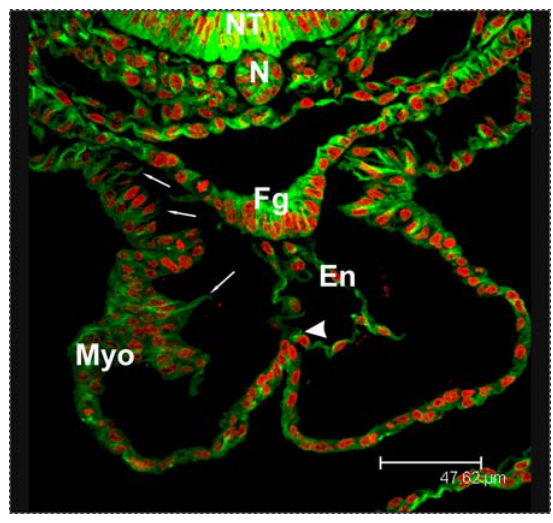
FIGURE 6 . HH stage 11 chick heart immunostained for acetylated tubulin. Myocardial cell processes extending into the cardiac jelly (see arrows) do not express acetylated tubulin that is observed usually in microcilia (arrowhead) and that are associated with endocardial-endothelial cells. This lack of tubulin expression in cardiomyocyte cell extensions into the ECM of the basal lamina and the RGD experiments suggest that myocardial mechanosensing of forces associated with blood flow would most likely be through integrin-mediated signaling. NT, neural tube; N, notochord; Fg, foregut; Myo, myocardium; En, endocardium. Magnification bar = 47.62 μ